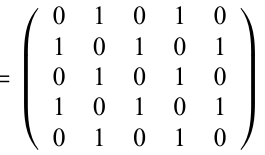
= 0.9 and (ρ ) ( 0 ) = 0.1, (ρ ) ( 0 ) = 0.3. The remaining Y Y 22 11 12